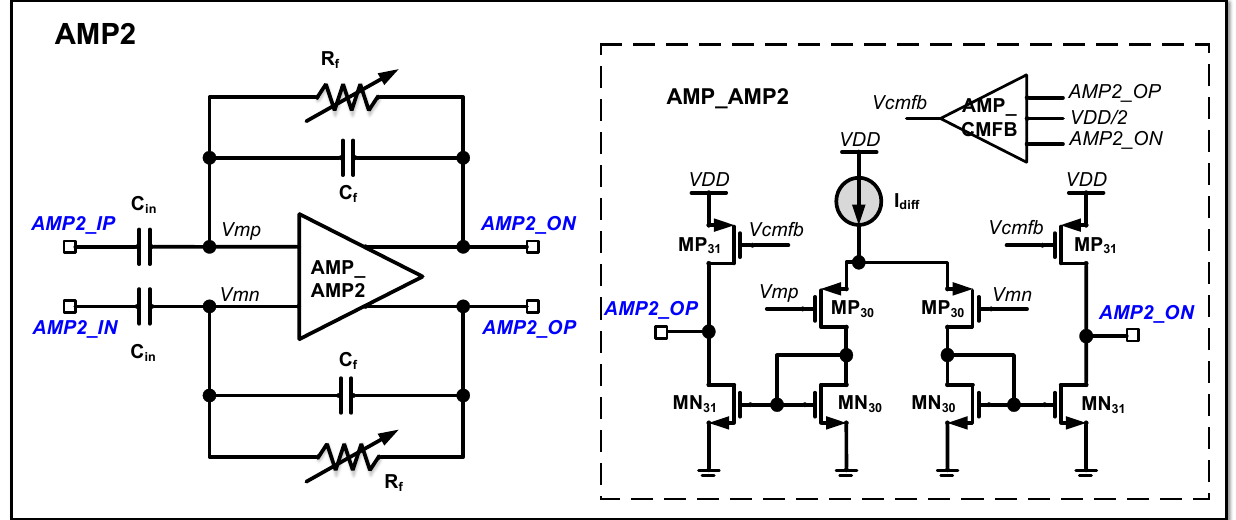
Figure 9. Detailed circuit diagram of the second amplifier (AMP2).